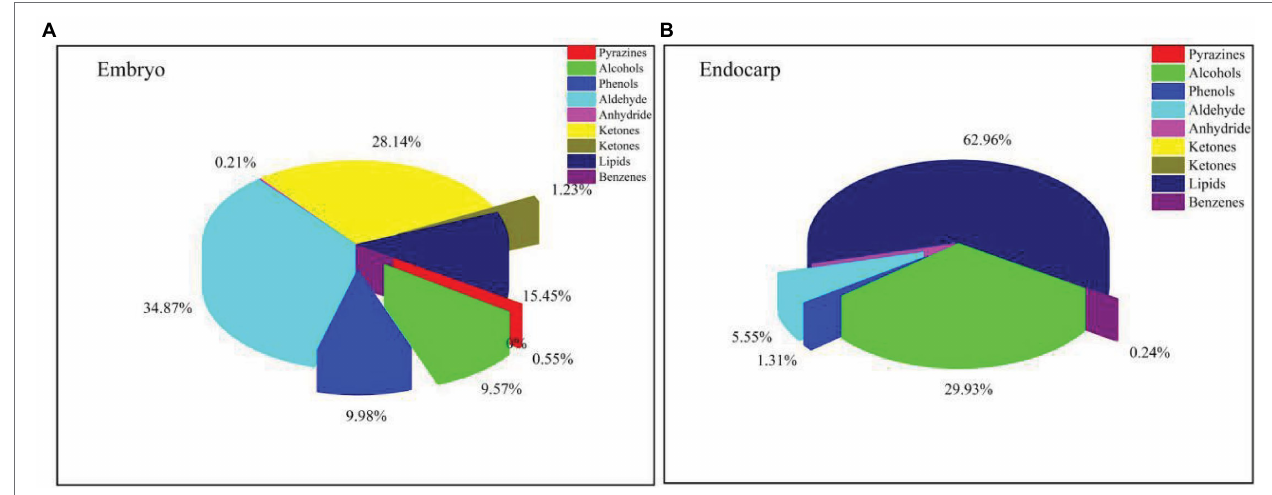
FIGURE 6 | Types and relative percentages of the identified compounds in Cinnamomum migao fruits. (A) , Methanol extract of the C. migao embryo, concentration: 1 g tissue (g ml − 1 ). (B) , Ethyl acetate extract of the C. migao endocarp, concentration: 1 g tissue (g ml − 1 ).